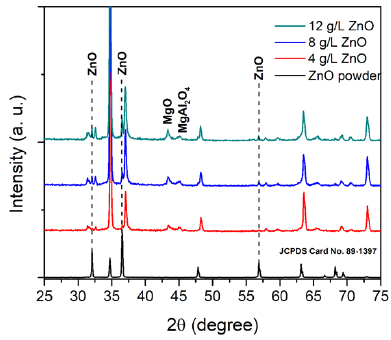
Figure 6. XRD patterns of ZnO powder and coatings formed in alumina electrolyte with addition of ZnO powder in various concentrations.